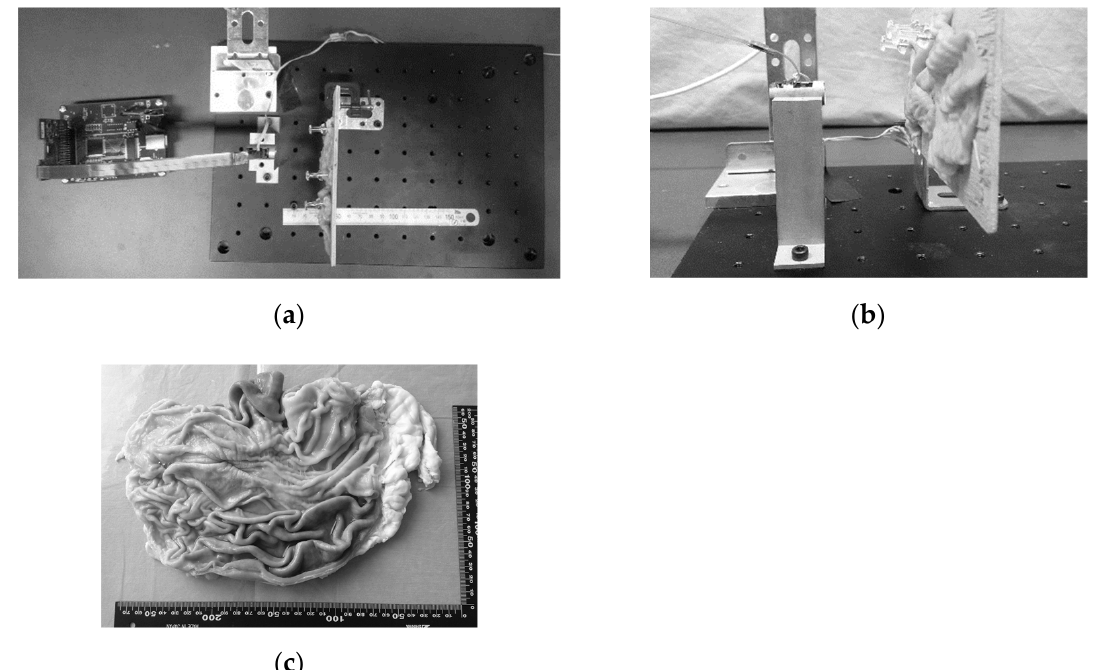
Figure 5. Shape measurement test with an in vitro porcine stomach. Experimental setup: ( a ) top view; ( b ) side view; and ( c ) substance.